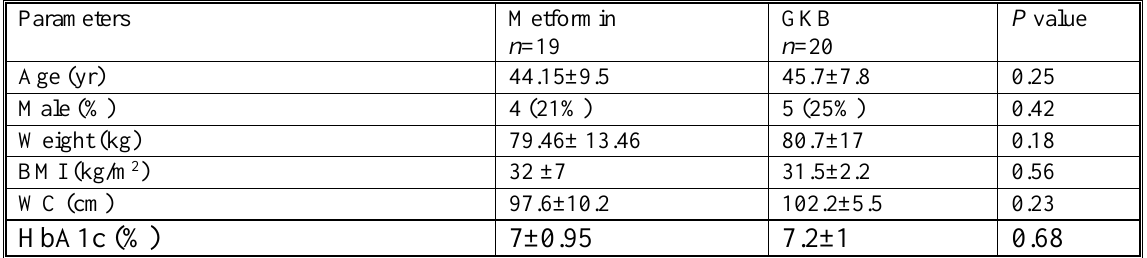
P-value consider significant if